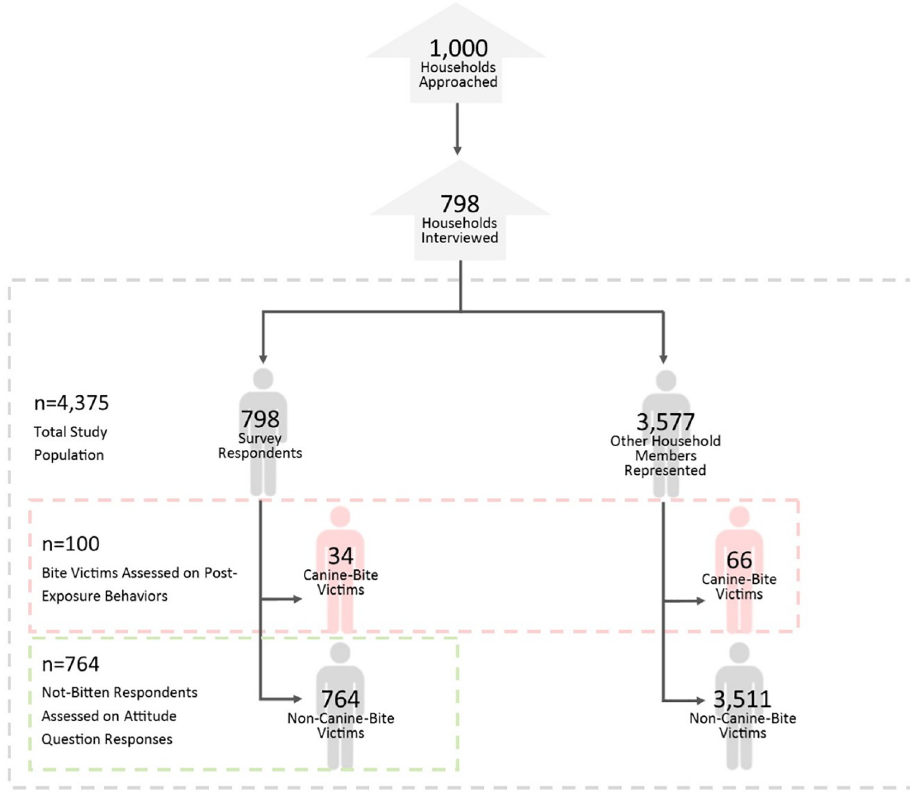
Fig 1. Study population by analysis